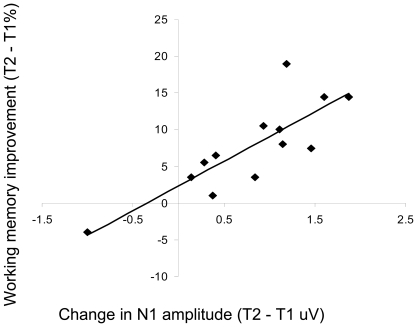
Neural-behavioral correlation.Across participants, decreased N1 amplitude during encoding correlated with WM performance improvements in the NI task at the original threshold in the training group (r = 0.82, p<0.001).